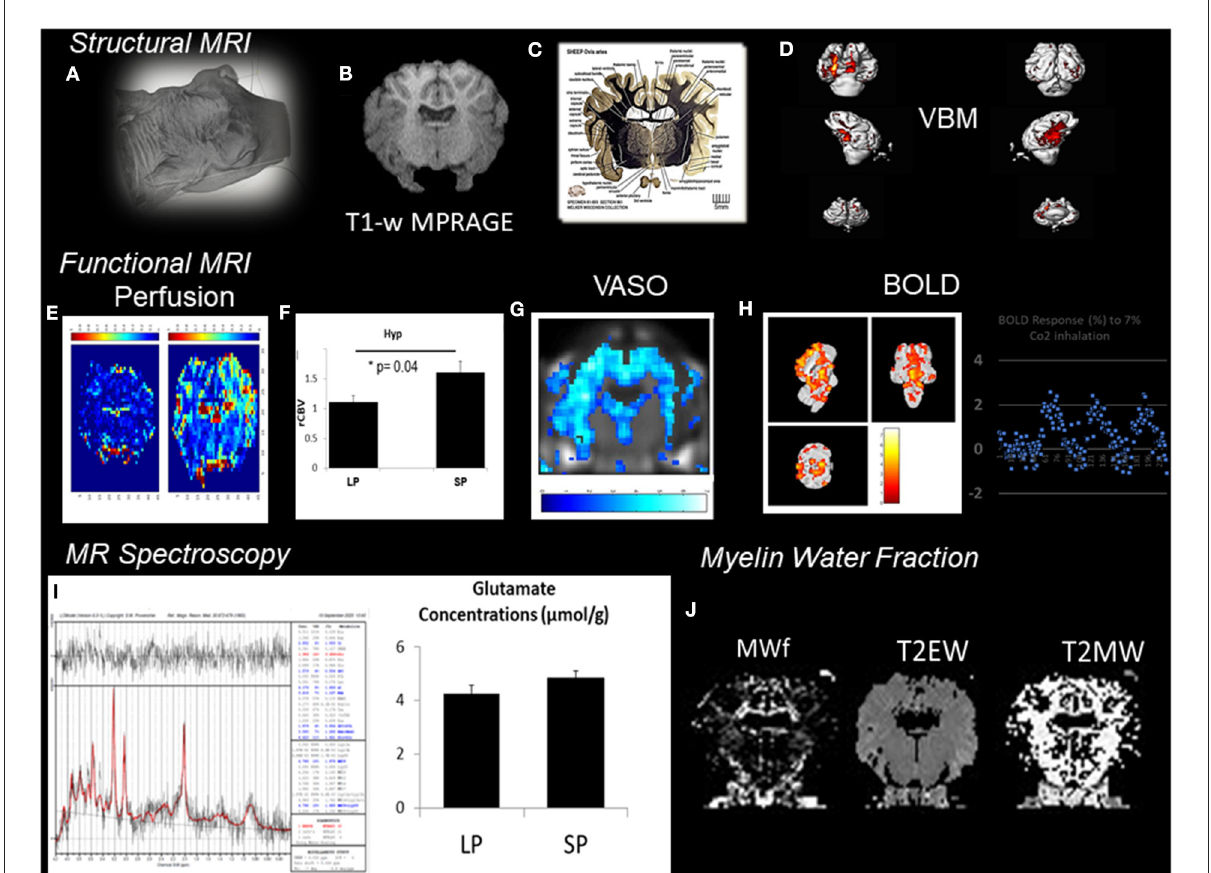
FIGURE2 Patchwork of different MR techniques used to explore the response of different structural and functional MR parameters to AN in the sheep hypothalamus during photopriodism. (A) Structural MR imaging and sensitivity to AN in the sheep hypothalamus. (B) VBM analysis conducted from the segmentation of MPRAGE images (0.5 × 0.5 × 0.2 mm 3 ). (C) Labeled fiber staining from the Sheep Brain Atlas (Michigan State University) showing the hypothalamus of the sheep with specific nuclei such as the arcuate nucleus. (D) VBM analysis detected significant structural changes occurring during the short days of the year (SP, short period) during AN compared to the long days of the year (LP, long period). (E) Functional MR imaging and sensitivity to AN rCBVmaps. (F) Comparison between LP and SP in the hypothalamus show a significant increase during SP (see Just et al., 2021b for methods). (G) Example of vascular occupancy (VASO) map during C02 inhalation. (H) BOLD fMRI upon hypercapnic challenge during SP (Chevillard et al., 2021). (I) 1 H-MRS of the hypothalamus demonstrated activation in hypothalamic areas and corresponded well to changes in glutamate. (J) Example of Myelin water fraction (MWf) and T2 maps. These examples were extracted from data, which are still under analysis but appear to show some consistent response among all the different MR modalities used with structural, functional, and hemodynamic changes occurring during the period of